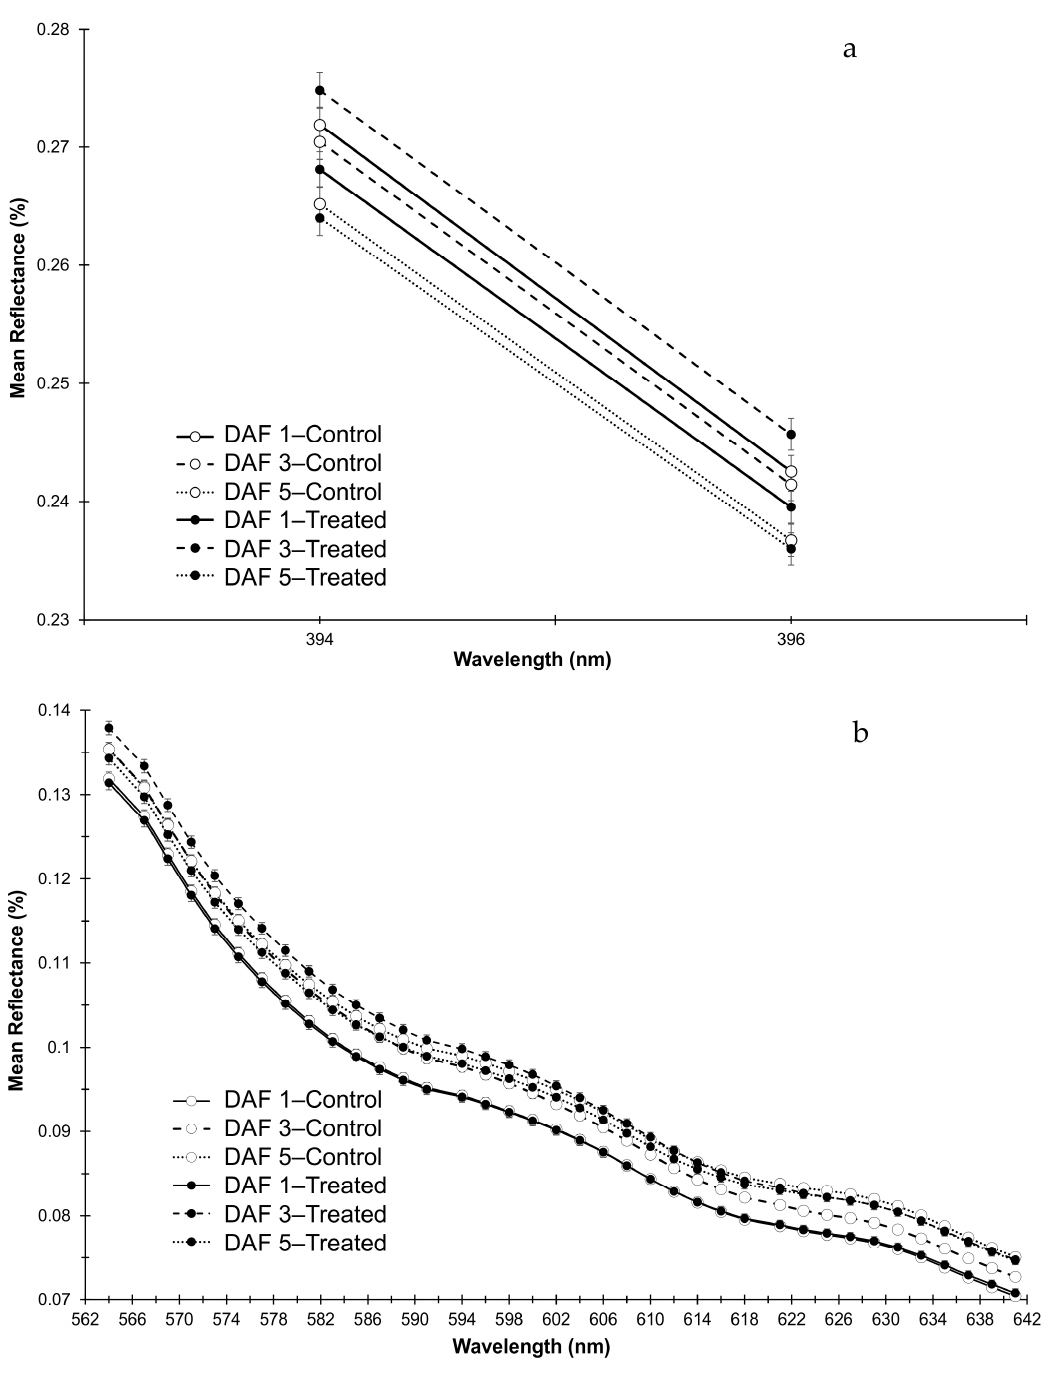
Figure 7. Mean spectral reflectance curves with SE bars ( n = 24) of leaf components across bands with significant interactions for (a) R 394-396 (PE) and (b) R 564-641 (Green/Red).